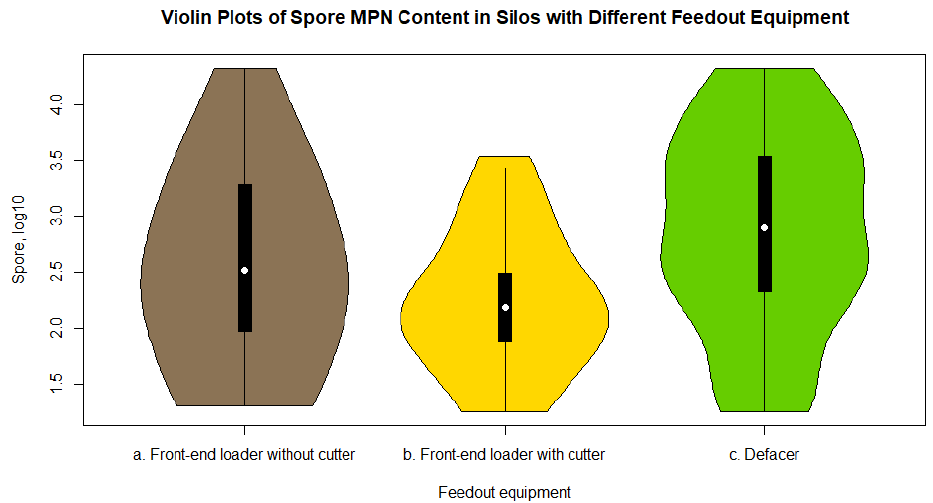
Figure 5. Distribution of anaerobic spore-forming bacteria spores (MPN, log 10 n/g) for the three types of feed-out equipment in the silo sampled within the study.